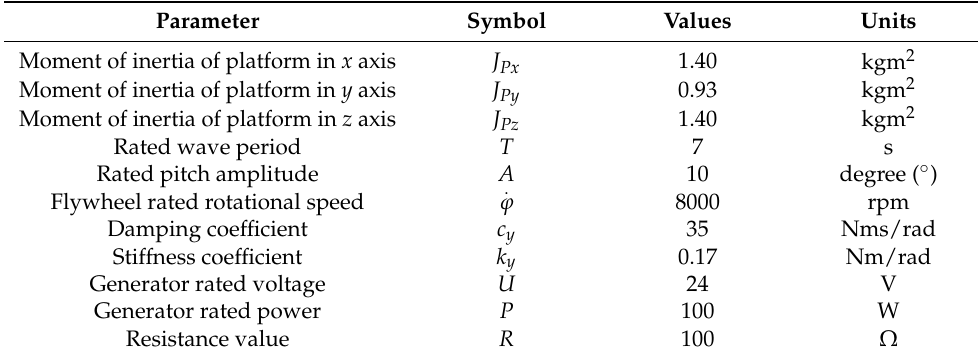
Table 2. Experimental platform parameters and rated working conditions. Parameter Symbol Values Units Moment of inertia of platform in x axis J Px Moment of inertia of platform in y